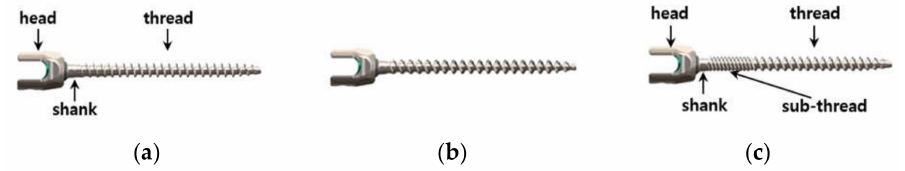
Figure 2. Various pedicle screws: ( a ) single, ( b ) double, ( c ), and the proposed